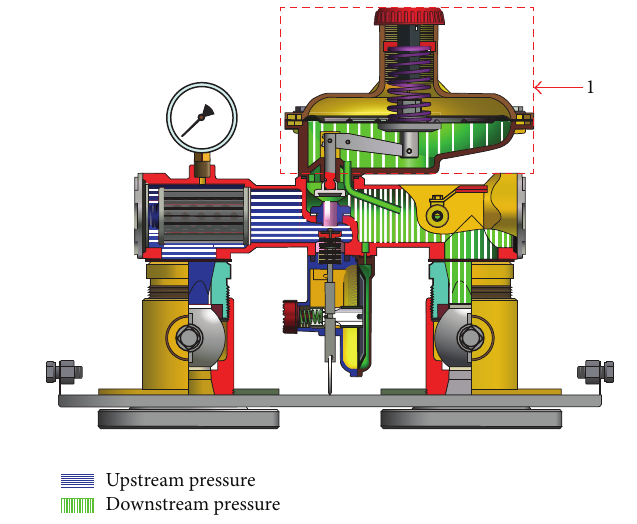
Figure 1: Self-actuated regulator.